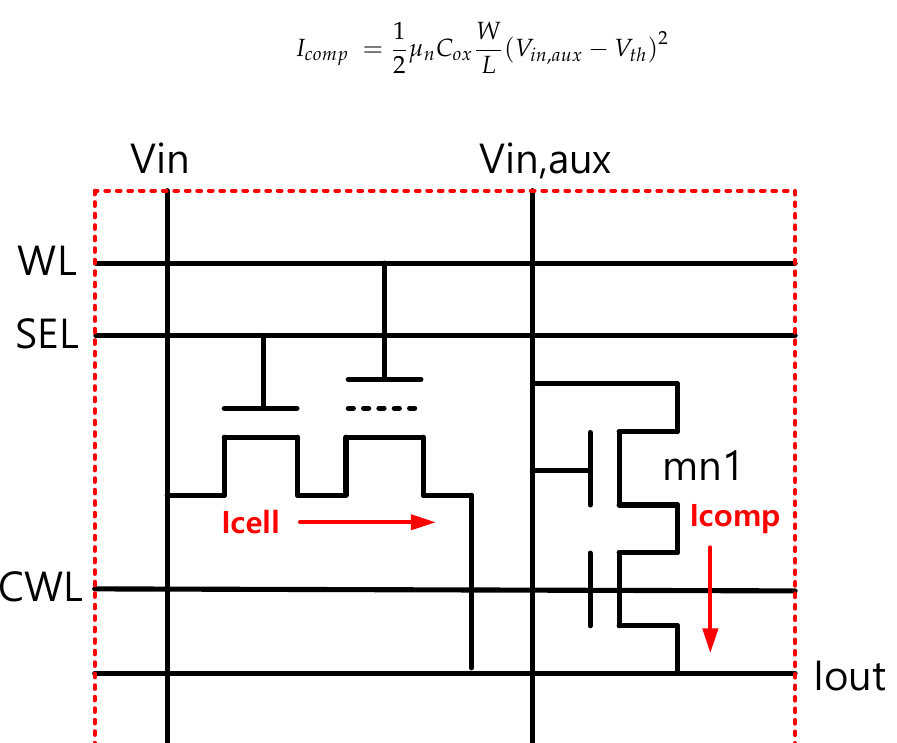
Figure 8. Proposed charge trap FET cell with auxiliary current path.